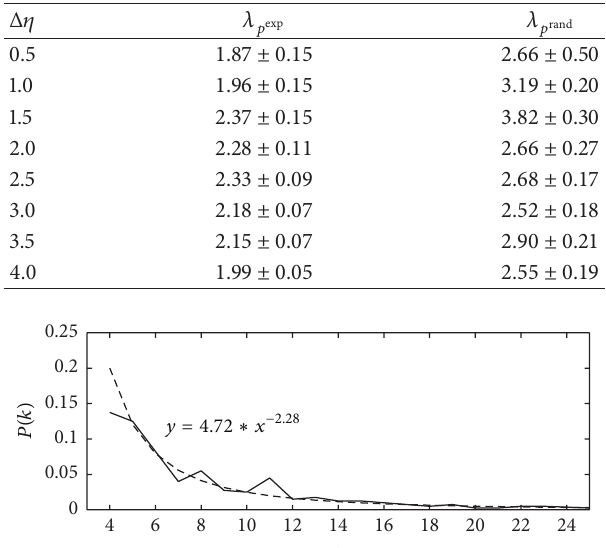
Figure 3: Slope of log 2 [1/𝑘] versus log 2 [𝑃(𝑘)] for the Visibility Graph created for the same dataset in Figure